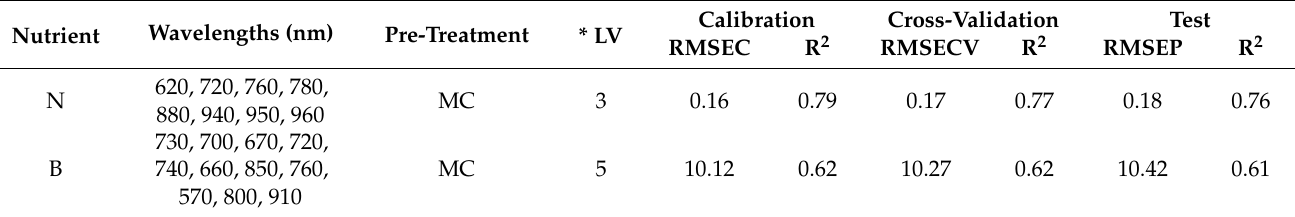
Table 4. Results of PLS-R using the selected bands for N and B.